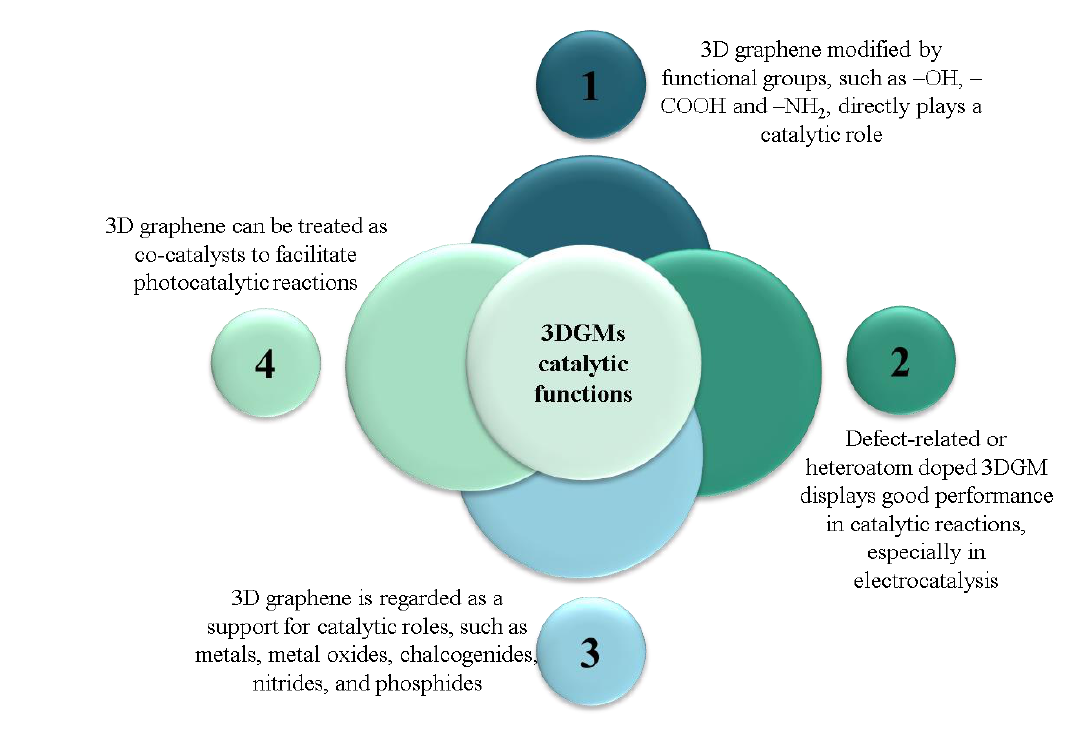
Figure 10. The main functions of 3DGMs in catalysis applications.